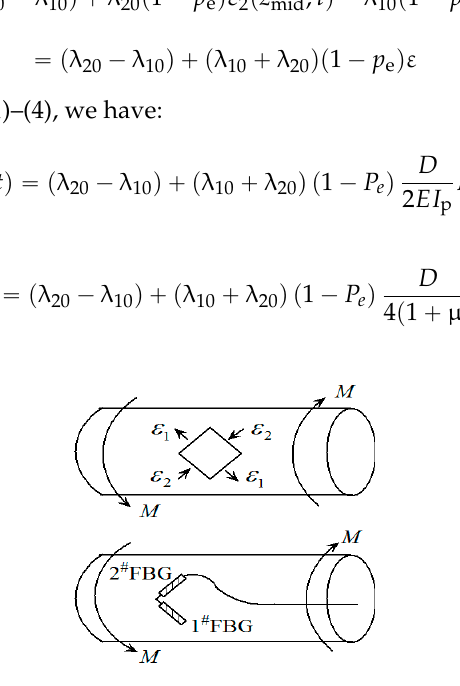
Figure 3. Two FBGs pasted along the maximum strain of the shaft torsion.